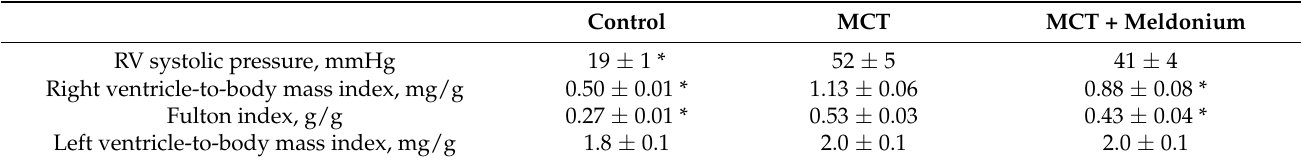
Table 1. Effects of meldonium administration on right ventricular (RV) systolic pressure, right ventricle-to-body, left ventricle-to-body mass indexes and Fulton index. Treatment with meldonium significantly attenuated the development of RV hypertrophy and had no effect on RV systolic pressure. Control